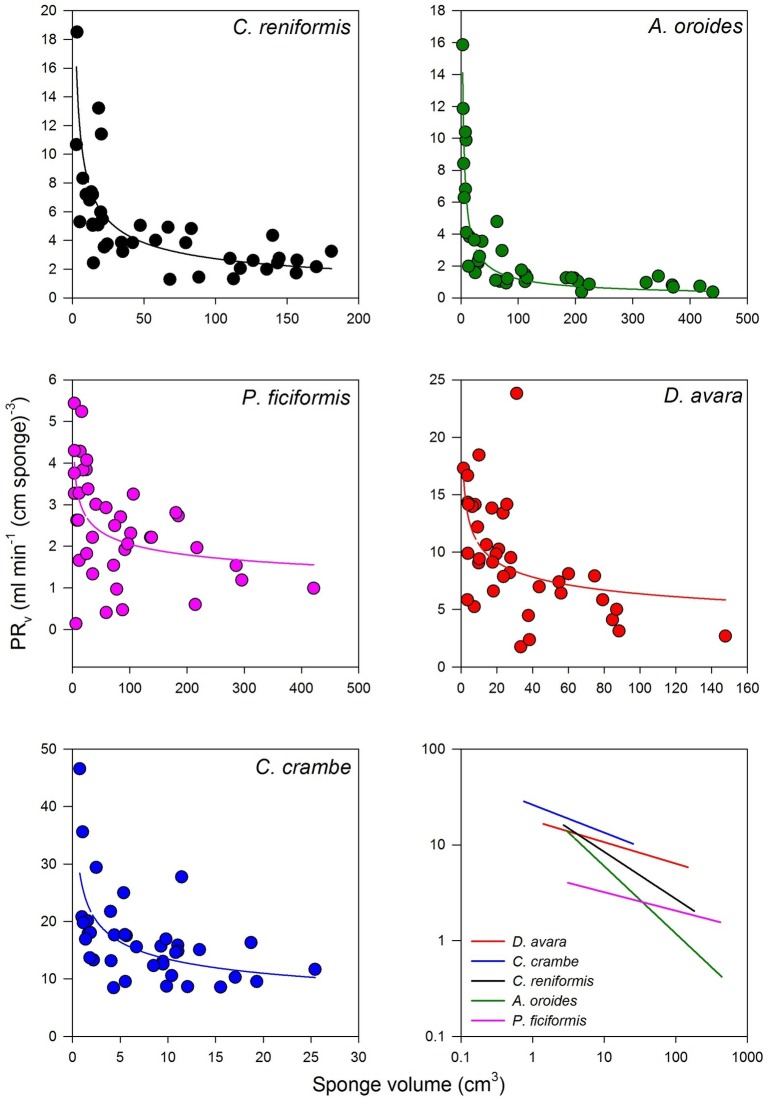
The relationships between the volume-specific pumping rate [PRV, ml min−1 (cm sponge)−3] and sponge volume (cm3) on multi-osculated specimens. The regression lines of all five species are plotted together on a log scale in the bottom right panel. The equations of the regression lines are shown in Table 5.